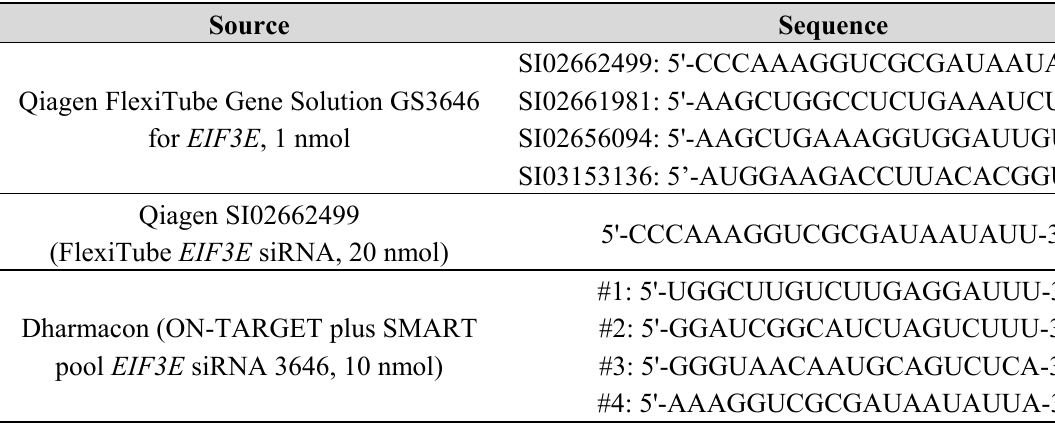
Table 1. Int6/EIF3E siRNA